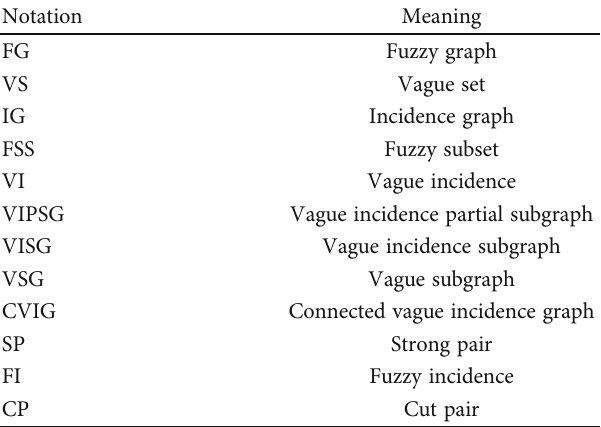
Table 1: Some basic